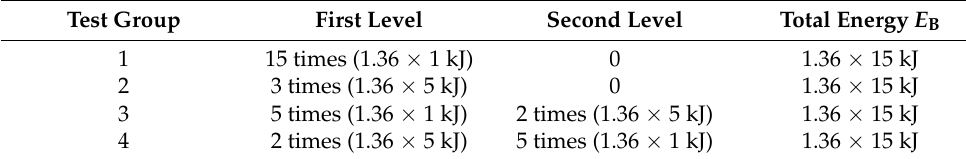
Table 2. Multi-level discharge energy control loading mode ( P c = 1 MPa and P h = 0 MPa). Test Group